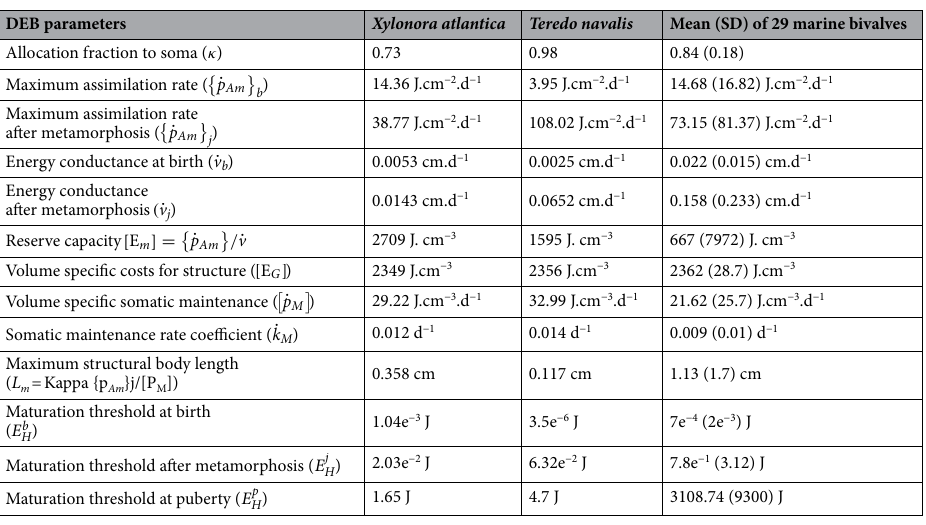
Table 2. Comparison of primary and core parameters of the abj-DEB model of the Atlantic woodeater Xylonora atlantica with those of Teredo navalis at T ref = 293 K (https:// www. bio. vu. nl/ thb/ deb/ deblab/ add_ my_ pet/ entri es_ web/ Teredo_ naval is/ Teredo_ naval is_ res. html) and the mean values of 29 marine bivalve species that are found in the AMP database (https:// www. bio. vu. nl/ thb/ deb/ deblab/ add_ my_ pet/ speci es_ list. html), where abj-DEB models were used. SD standard